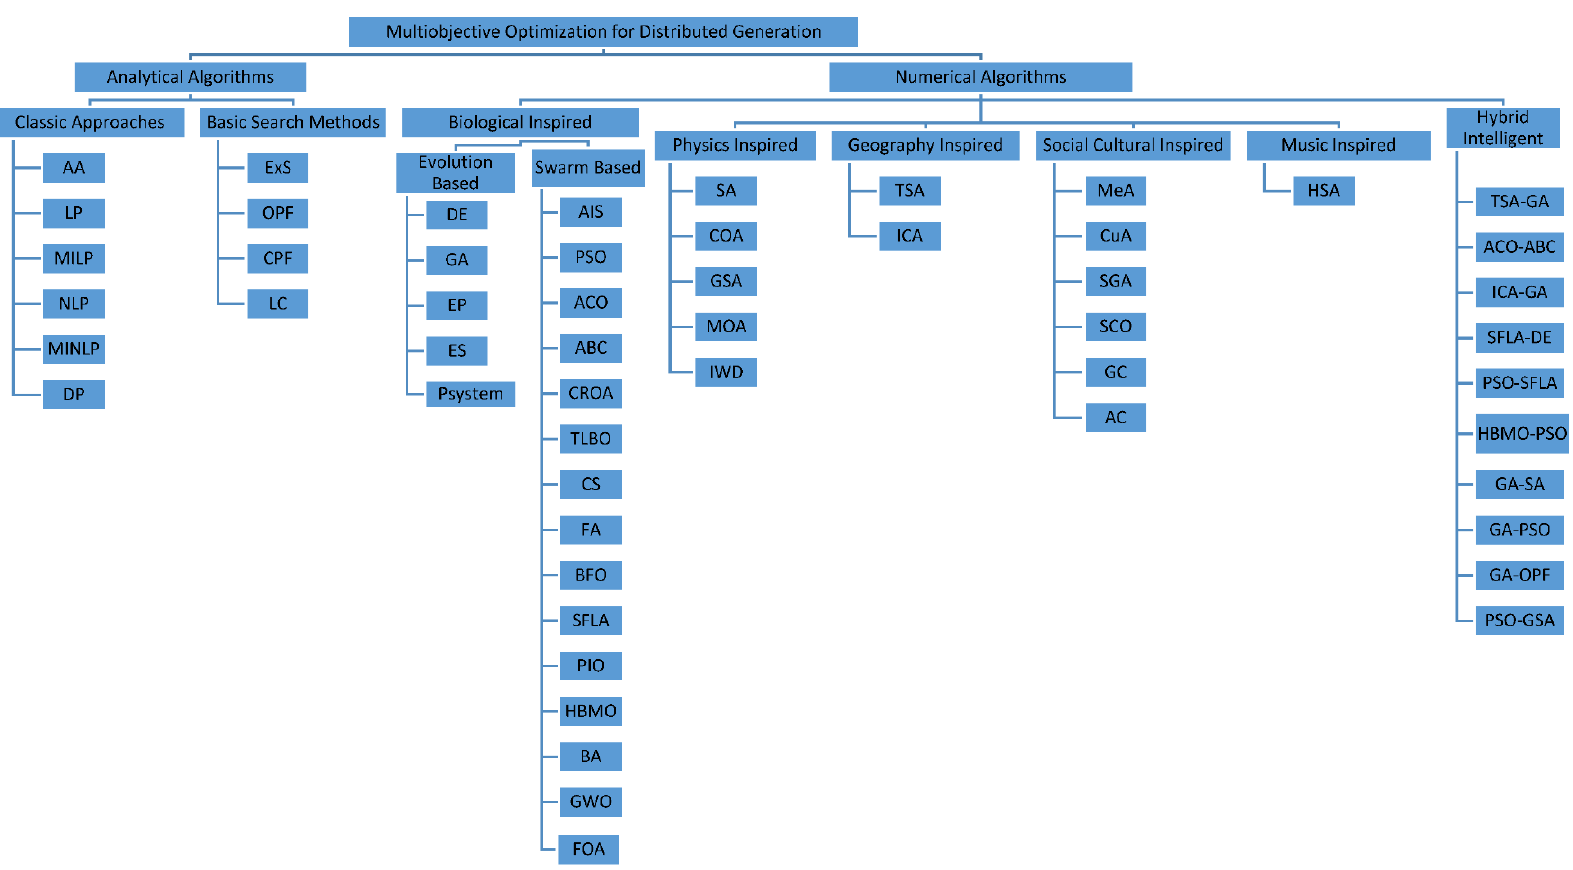
COA — cuckoo optimization algorithm, TSA — tree speed algorithm, HAS — harmony search algorithm.